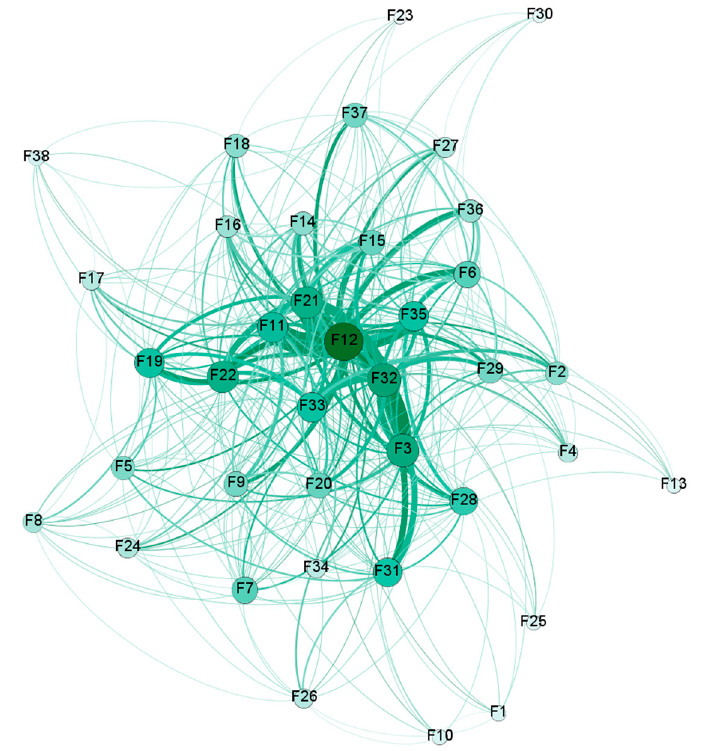
Figure 3. Representations of cost overrun factors’ network.